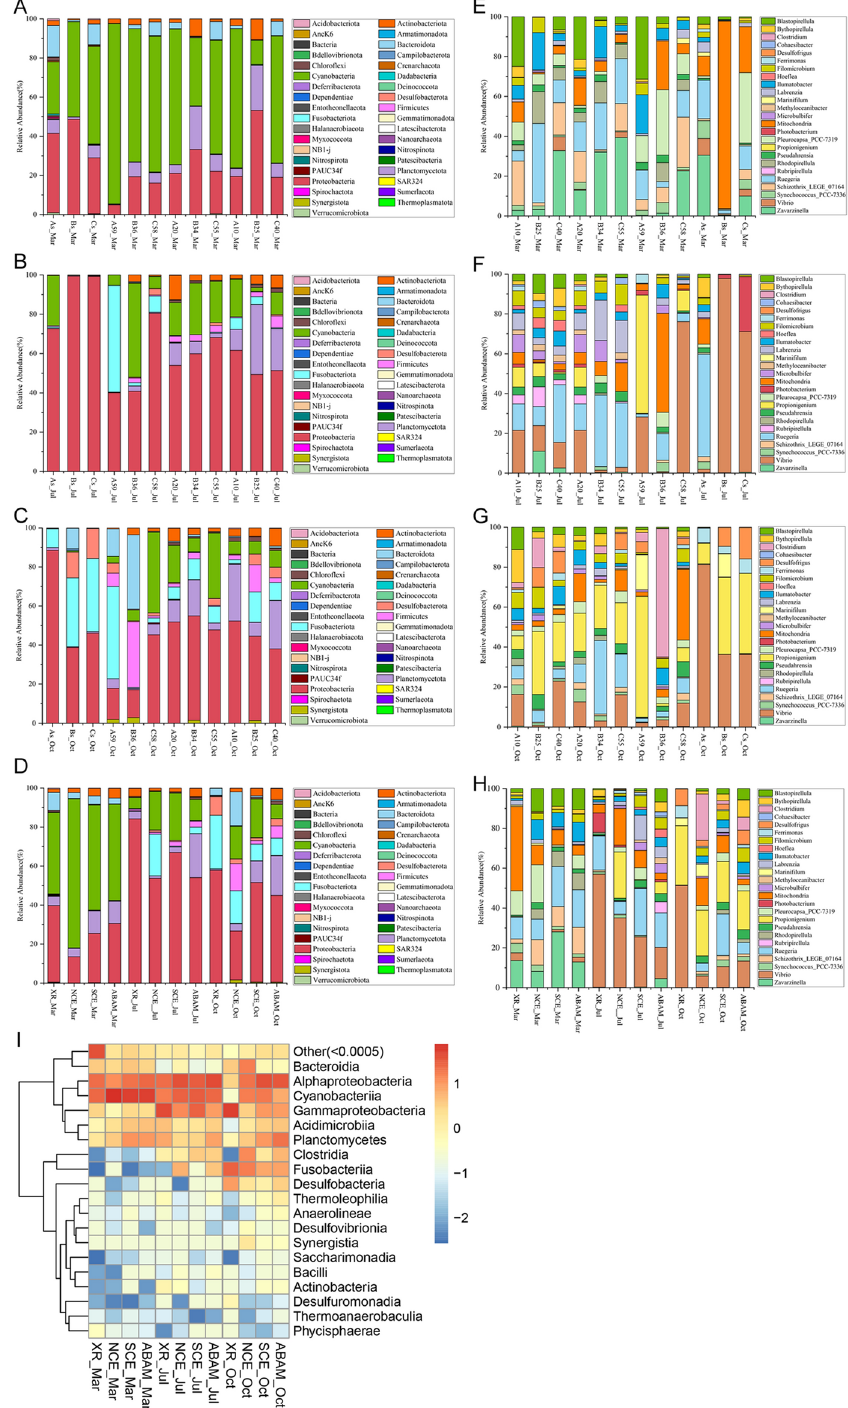
Figure 1. Temporal dynamics of the relative abundances of top bacterial phyla and genera of the three sampling treatments (ABAM, SCE and NCE) Plus the samples from the natural environment (XR) for the three different localities. ( A – C ) Relative abundance of key bacterial Phyla in March, July, and October respectively. ( D ) Relative abundance of key bacterial Phyla of total bacteria grouped for all three localities with the different treatments plus the XR. ( E – G ) Relative abundance of dominant bacterial genera in March, July, and October respectively. ( H ) Relative abundance of key bacterial Genera of total bacteria grouped for all three localities with the different treatments plus the XR ( I ) Heat map of the relative abundance of the 20 most abundant classes over